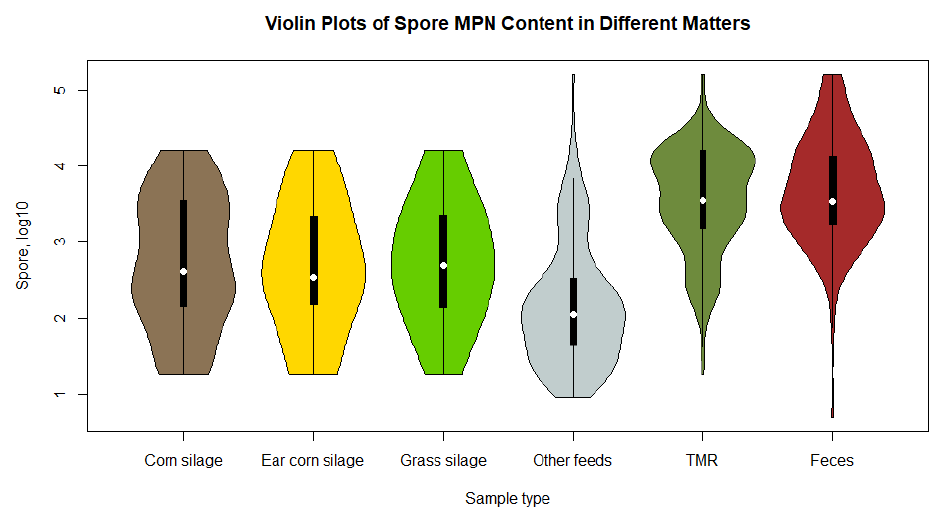
Figure 2. Distribution of anaerobic spore-forming bacteria spores (MPN, log 10 n /g) for the main silages included in the TMR and for the remaining feeds, for TMR, and for feces collected within the study.